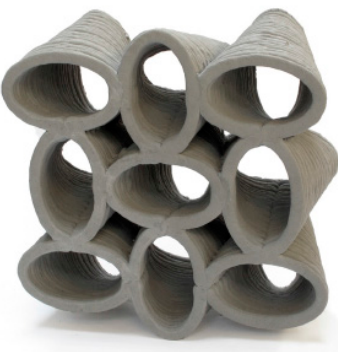
Figure 9. 3D printed acoustic damping wall (Reproduced with permission from: [44], Materials and Design; published by Science Direct, 2016).